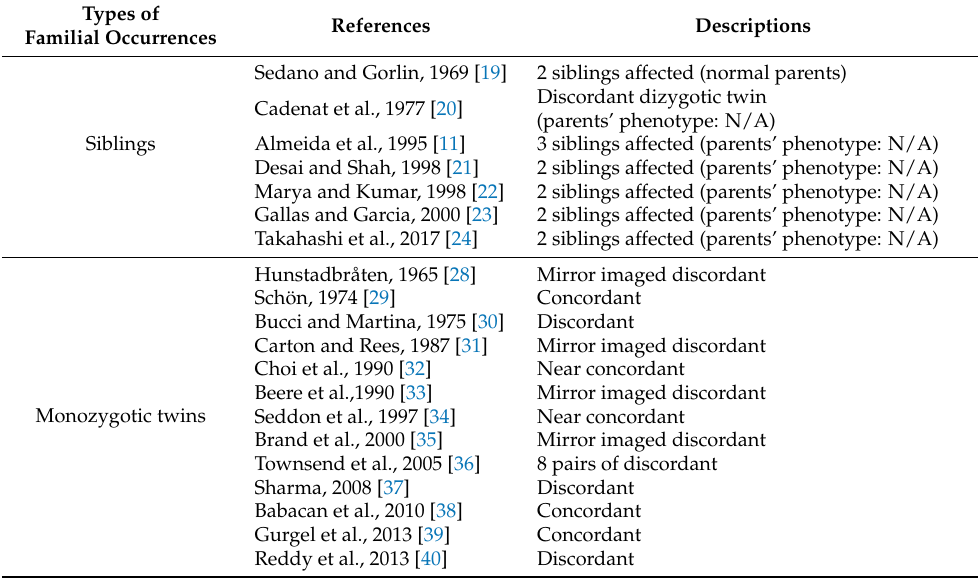
Table 3. Published reports of familial occurrence of